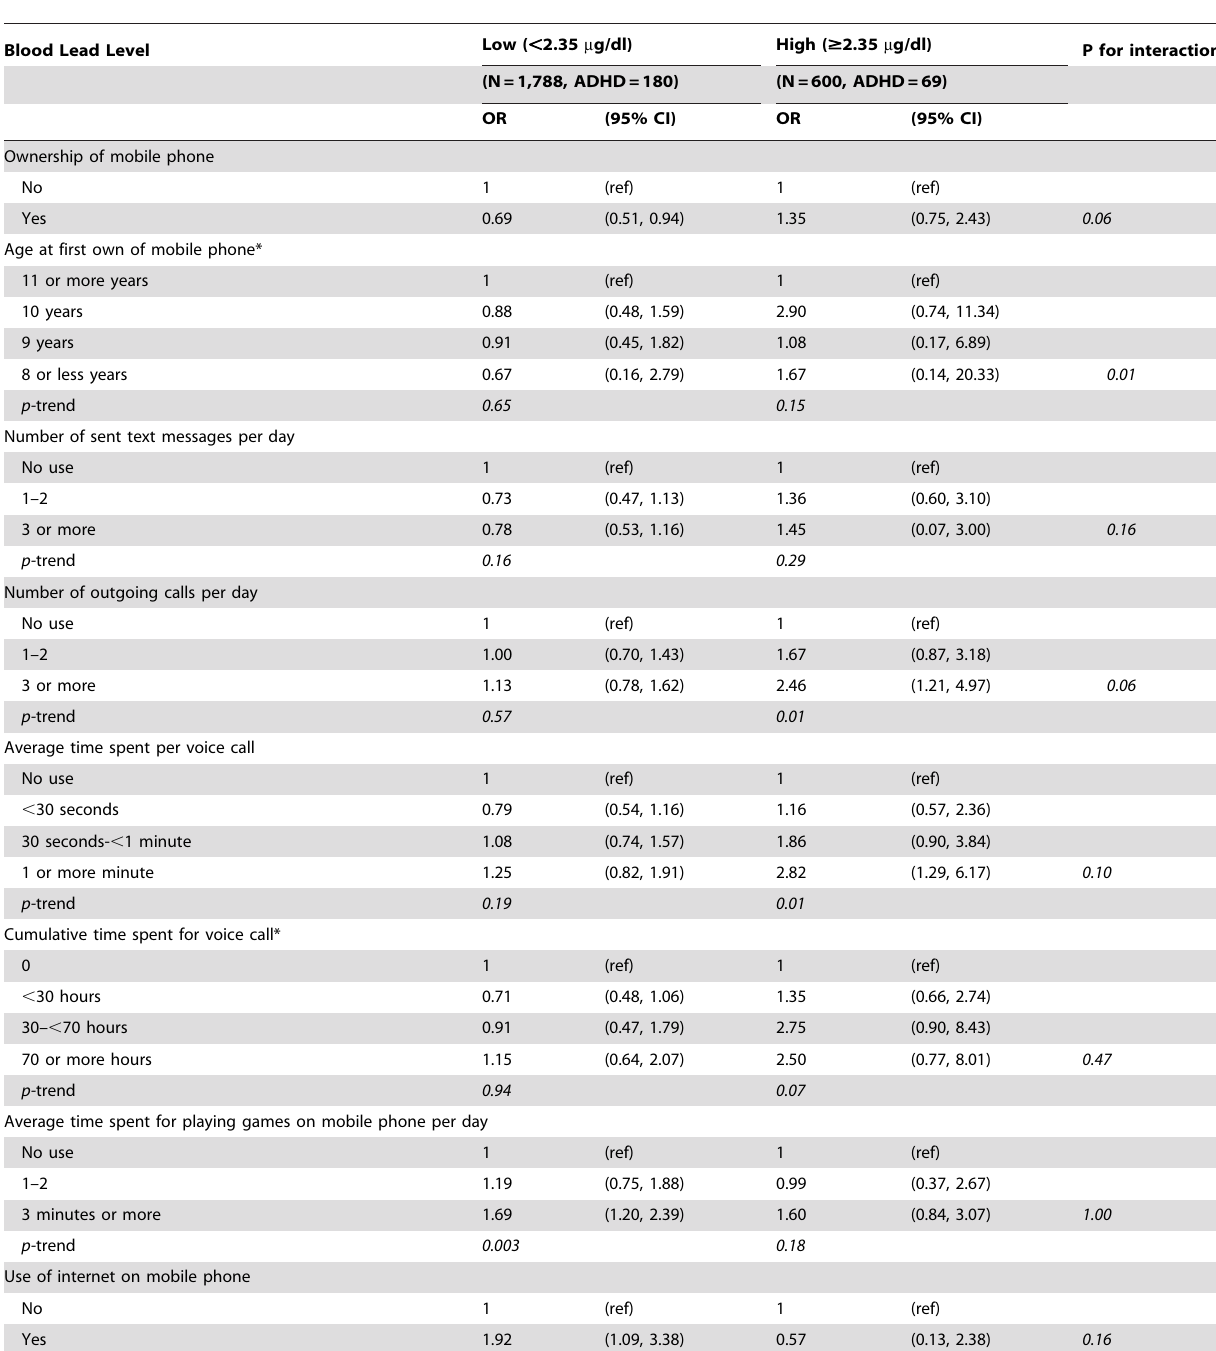
Table 3. Association Between Mobile Phone Use and ADHD in Children Stratified by the Blood Lead Level in 2008 and 2010, Korea, the CHEER